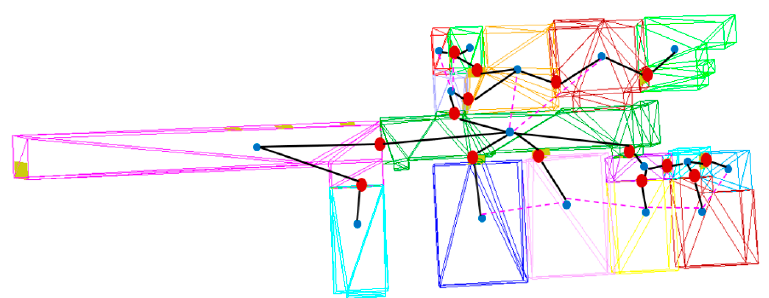
Figure 13. The rooms with topological relationship (the solid lines are connected by the doors, and the dotted lines are the connected by adjacent walls).